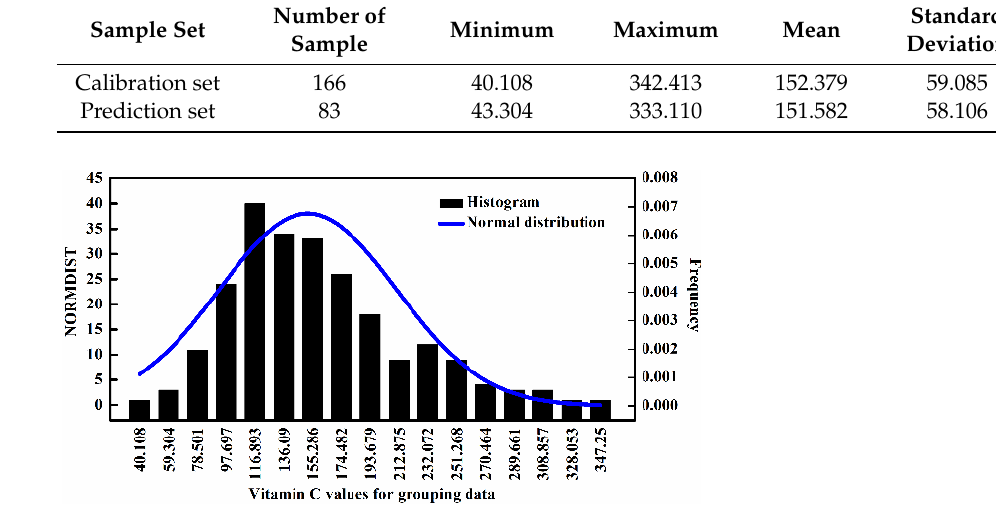
Figure 1. Normal distribution of measured vitamin C values.